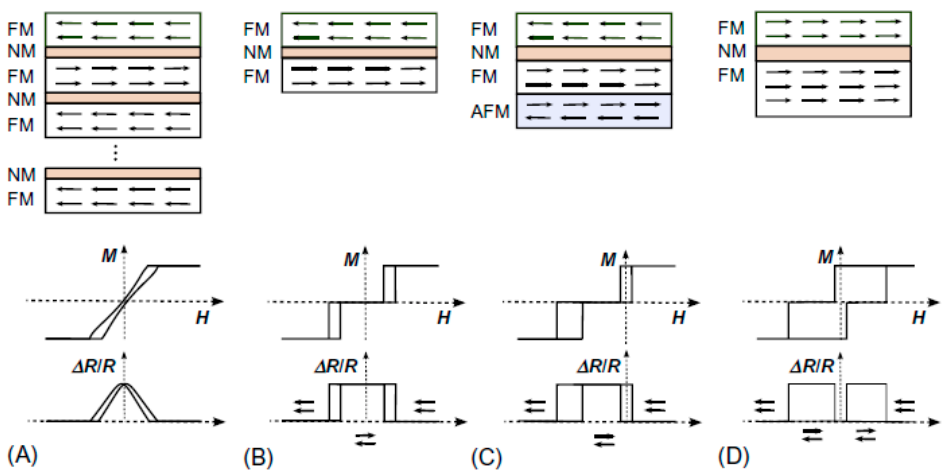
Figure 5. Schemes of several spin-valve configurations: Multilayer spin-valve, consisting of the repetition several times of two identical magnetic layers coupled antiferromagnetically ( A ); Bilayer spin valve, which consists of two identical magnetic layers coupled antiferromagnetically ( B ); Exchange bias spin valve, in which one of the magnetic layers is exchanged biased to an antiferromagnetic layer. Hence, the free layer on top can rotate nearly independently of the bottom layer, which acts as a reference/pinned magnetic layer ( C ); Pseudo spin-valve, consisting of a magnetically soft layer that can rotate nearly freely in relation to a hard ferromagnetic layer (which can be a different and/or a thicker ferromagnetic layer) ( D ). In each panel, the corresponding sketches of the hysteresis loops (middle) and the relative change in magnetoresistance (bottom) are also shown. Reprinted with permission from ref. [1] with permission from 2018 Elsevier.